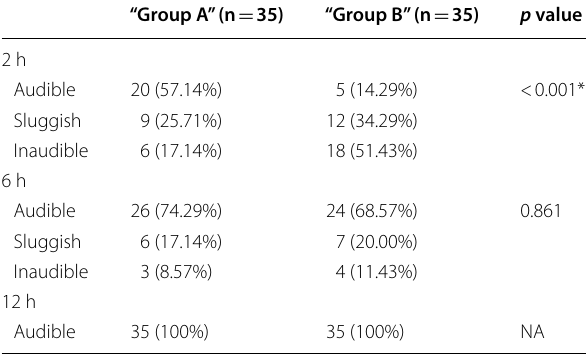
Pearson chi-square test was used for qualitative data between both groups; Values are expressed as number and percentage *Statistically significant ( p 0.05) ≤